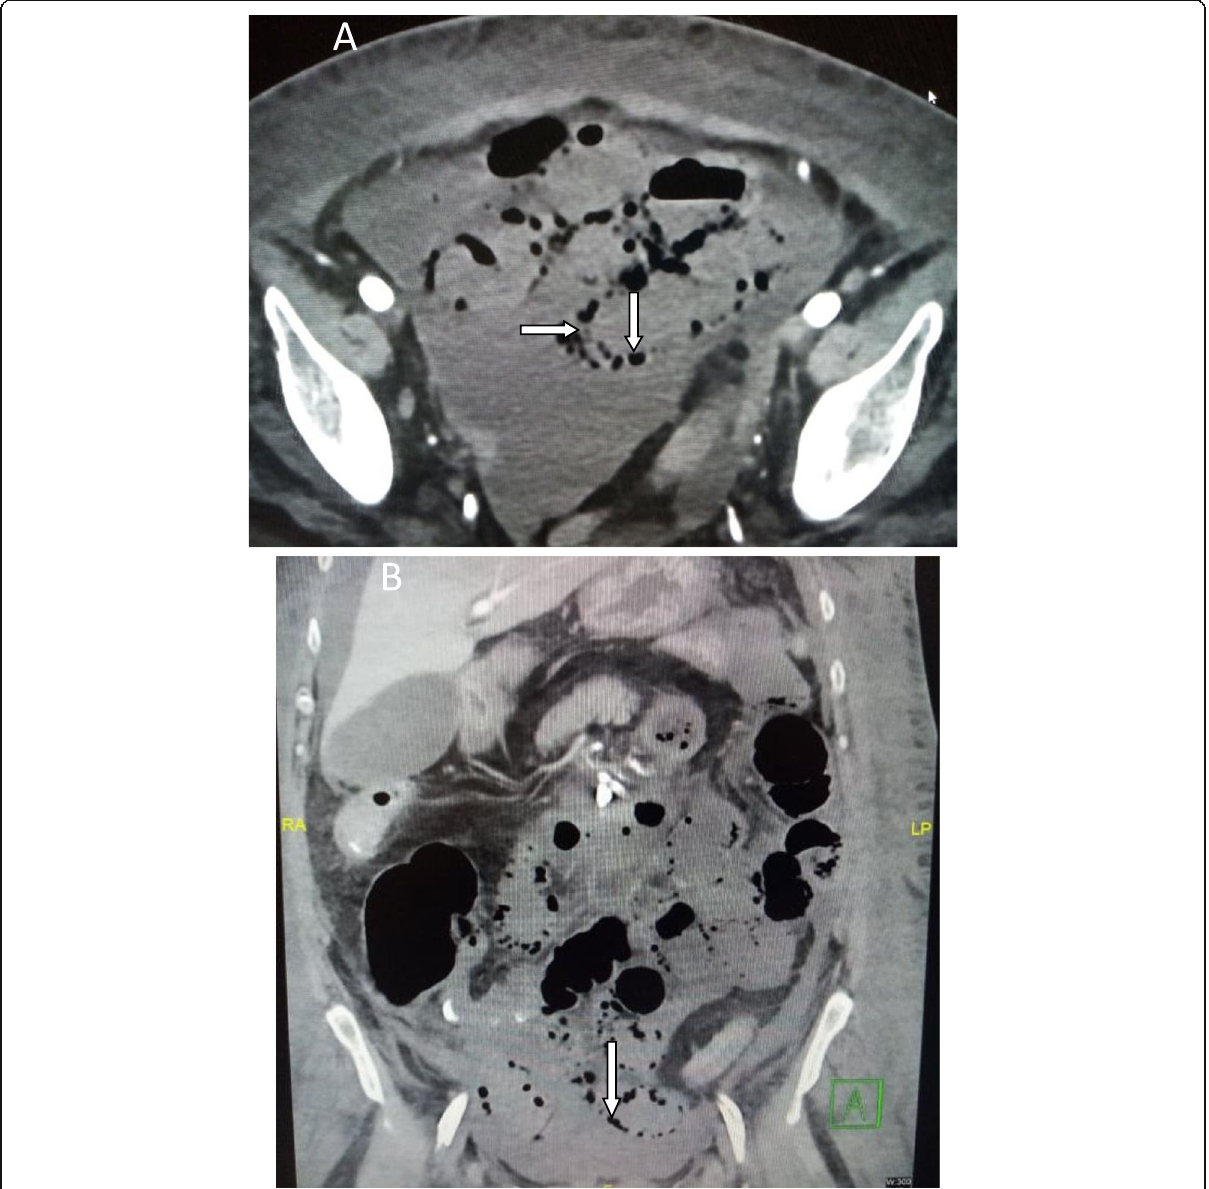
Fig. 2 Seventy-year-old COVID-19 female patient isolated in the ICU presented with marked abdominal distention. a axial and b coronal CT of the abdomen show positive pneumatosis intestinalis (open arrows) and related